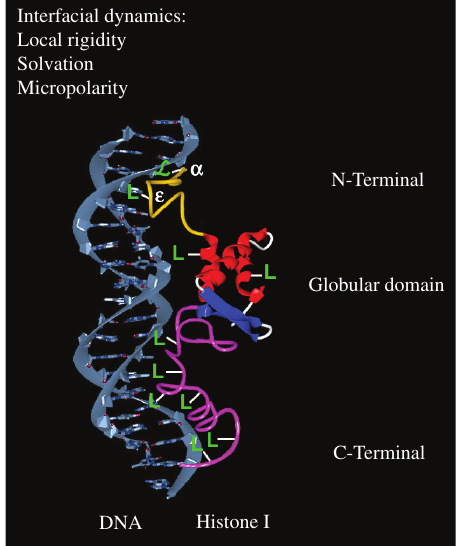
Figure 9 Model of the interaction between the protein H1 and DNA, showing the interfacial dynamics studied through the covalent and noncovalent labeling of ligands ( e and L) to the protein.